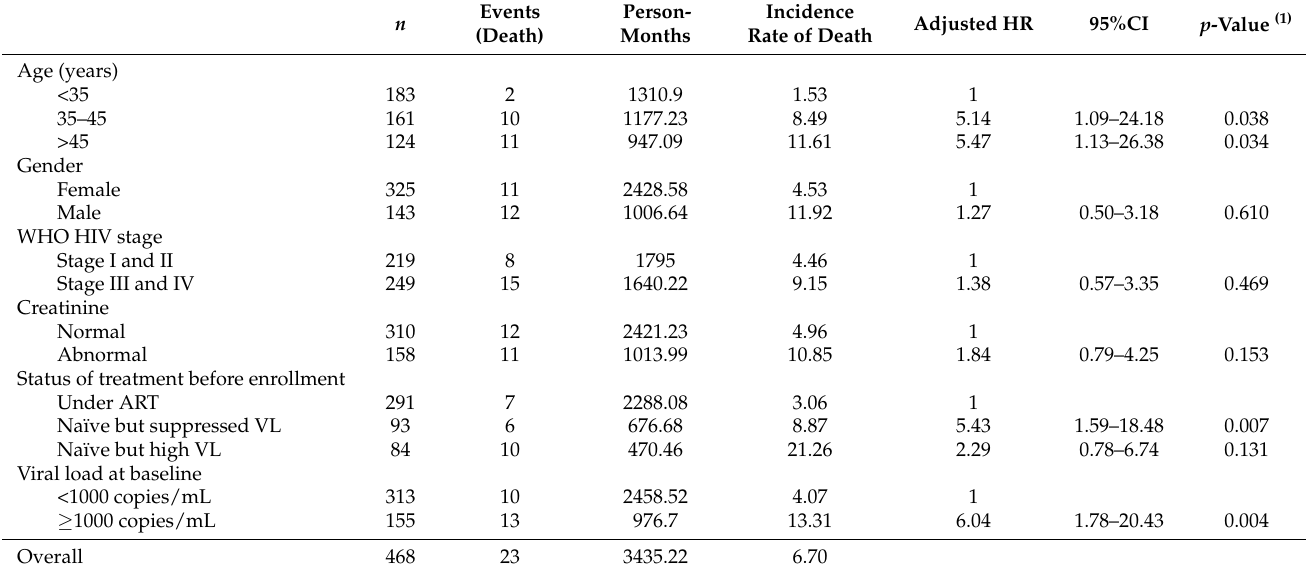
Table 3. Multivariate analysis of predictors of mortality ( n = 468).